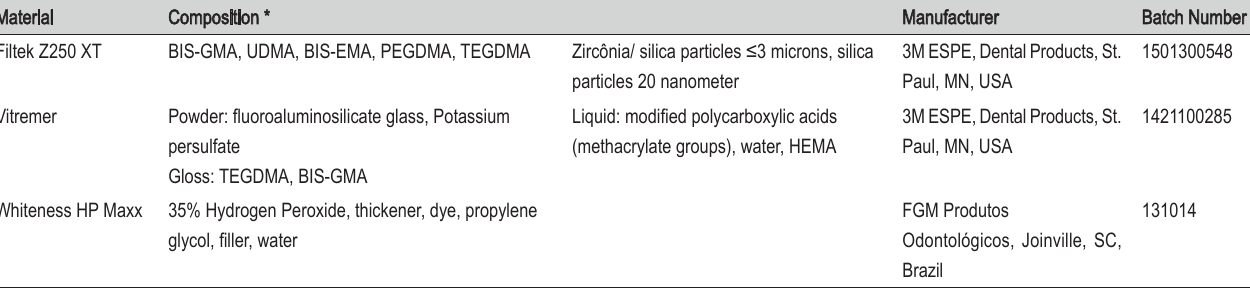
Table 1 - Chemical composition and manufacturer of materials used in the present